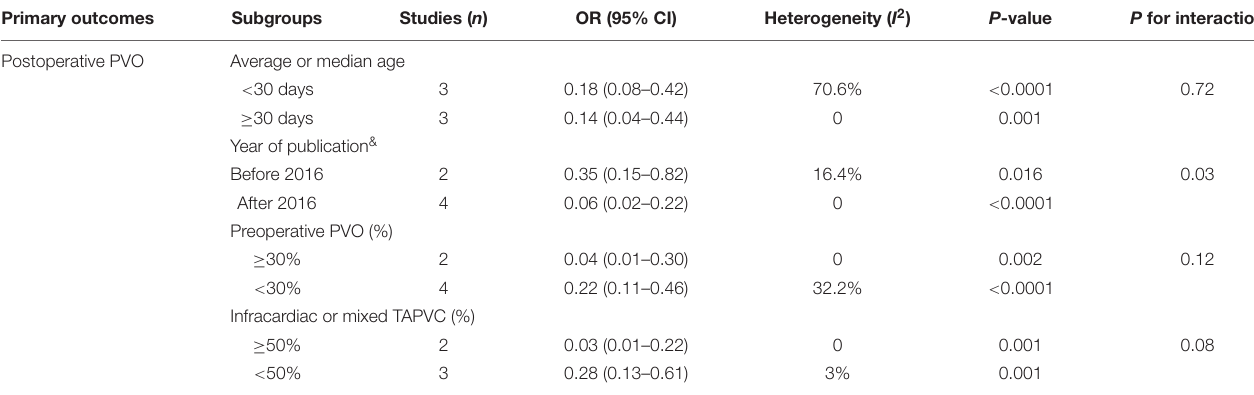
TABLE 3 | Subgroup analysis of postoperative PVO based on two-arm studies*. Primary